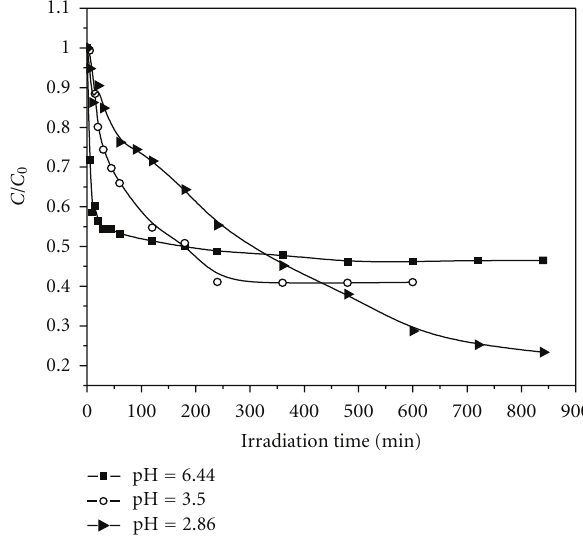
Figure 11: m-cresol disappearance in the mixture up on irradiation (365nm) at di ff erent complex concentrations: (cid:5) Without Fe(III)- Cit, • [Fe(III)-Cit] = 0.2 mM, (cid:3) [Fe(III)-Cit] = 0.3 mM, (cid:7) [Fe(III)- Cit] = 0.47